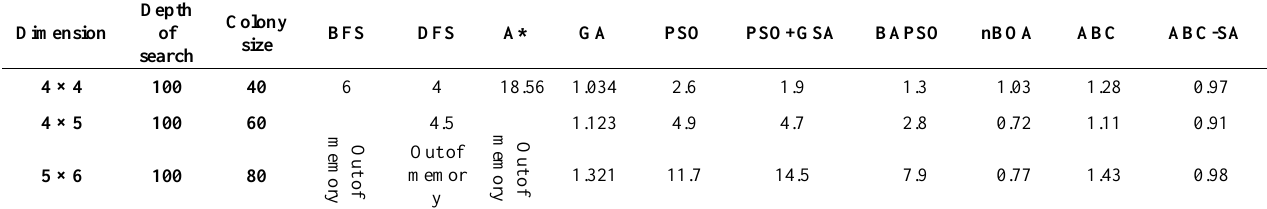
Table 3. Experimental results of different approaches to the Pacman problem (average response time (s)). Depth Dimension of